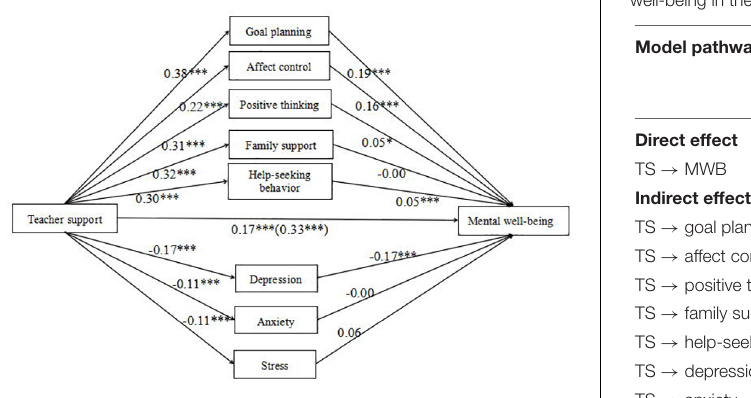
FIGURE 3 | Parallel mediation model showing the individual dimensions of negative emotions and resilience in the relationship between teacher support and mental well-being. N = 1199. The total effect of teacher support is shown in parentheses. Goal planning, affect control, positive thinking, family support, and help-seeking behavior belong to resilience. Depression, anxiety, and stress belong to negative emotions. * p < 0.05, *** p < 0.001.